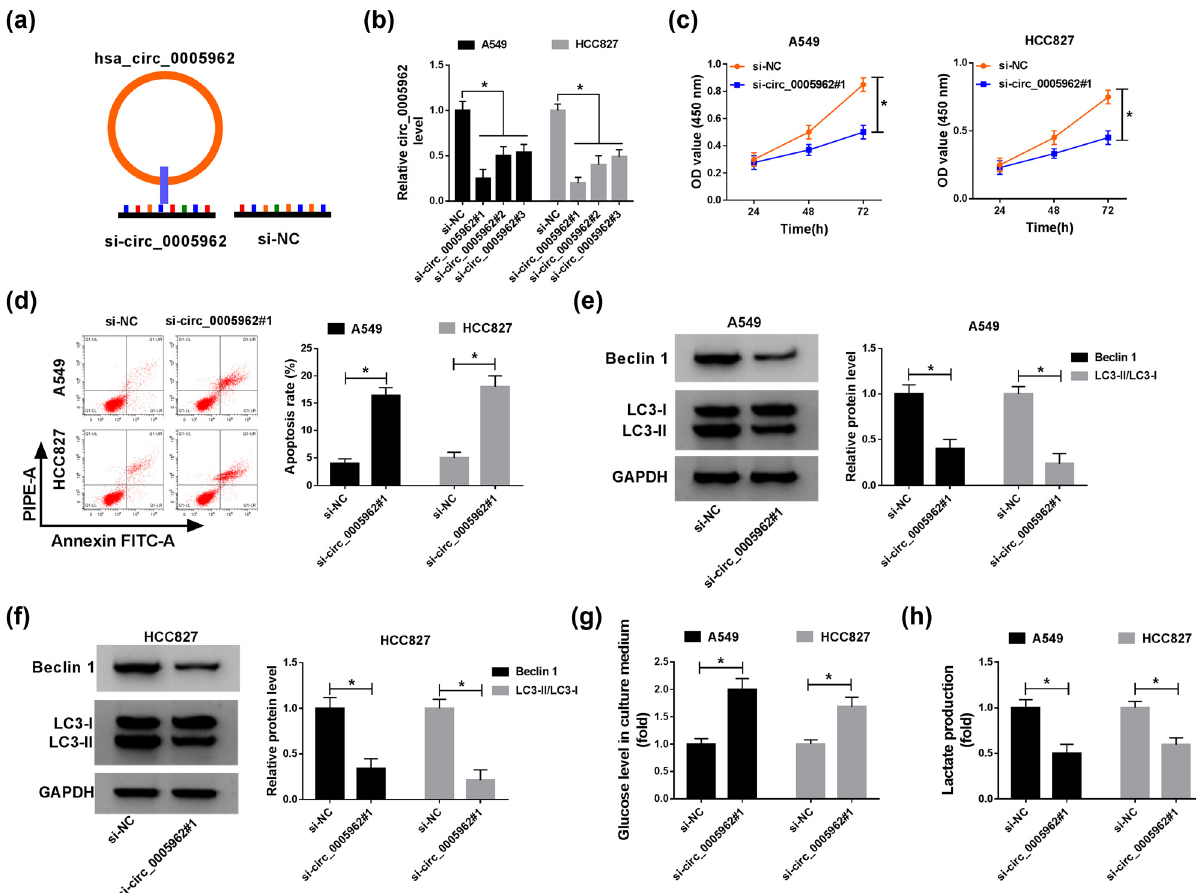
Figure 2: circ_0005962 knockdown inhibited proliferation, autophagy, and glycolysis but contributed to apoptosis in NSCLC cells. ( a ) The diagram of circ_0005962 knockdown. ( b ) The e ffi ciency of circ_0005962 knockdown in di ff erent transfection lines was detected by qPCR. A549 and HCC827 cells were transfected with si - circ_0005962#1 or si - NC. ( c ) Cell proliferation was assessed by CCK - 8 assay. ( d ) Cell apoptosis was executed by fl ow cytometry assay. ( e and f ) The protein levels of Beclin 1 and LC3 - II/LC3 - I were quanti fi ed by western blot. ( g and h ) The glycolysis progression was evaluated according to the level of glucose in culture medium and lactate production. * P <